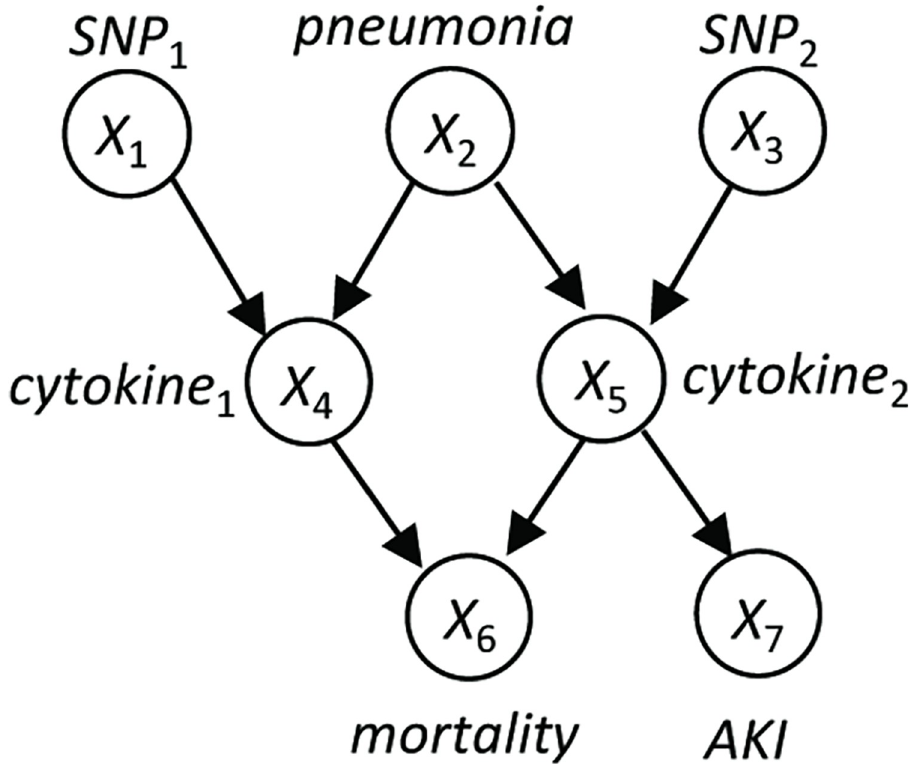
Fig 7. A hypothetical medical Bayesian network structure with 7 variables represented as nodes. This structure is presented for illustration only and is not intended to present an accurate and complete model of the causal relationships involving pneumonia and mortality. The variables cytokine 1 and cytokine 2 represent two specific types of circulating cytokines associated with inflammatory disease. SNP 1 and SNP 2 are particular single nucleotide polymorphisms (SNPs) that represent genetic point variations. AKI is acute kidney